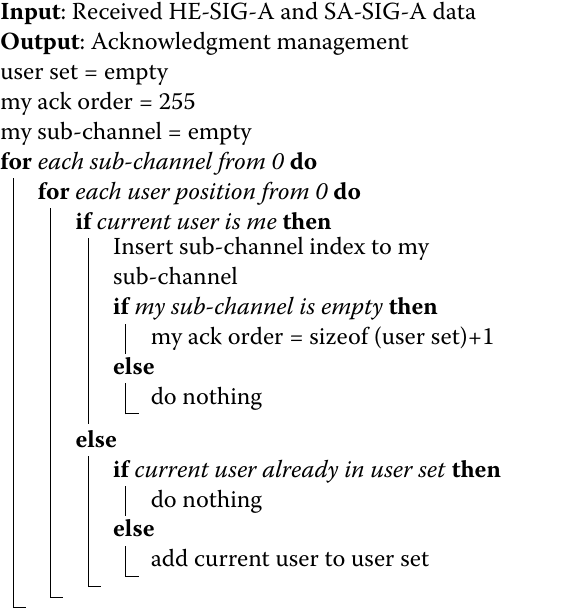
Algorithm 2: Distributed Acknowledgment Manage-